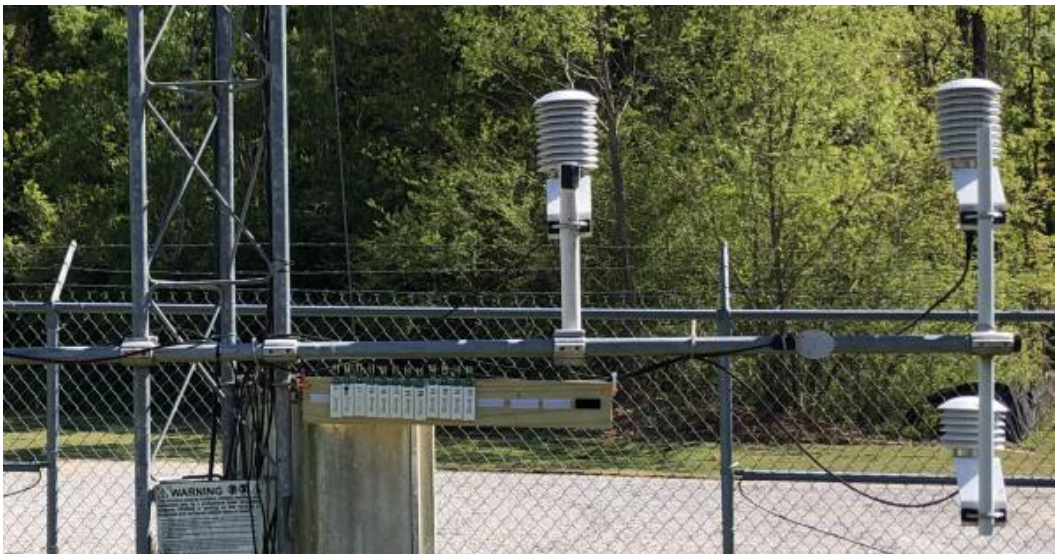
Figure 1. Photo of all 12 iMET-XQ sensors mounted side-by-side on the 2 m cross-arm of the South Alabama Mesonet tower. Bottom right, below the cross-arm, is the radiation shield containing the model 107 thermistor probe from Campbell Scientific Inc. The HMP-45C Temperature/Relative Humidity probe is installed in the radiation shield on the top right. The identical radiation shield on the left contains an iMET-XQ sensor in the Radiation Shield experiments.